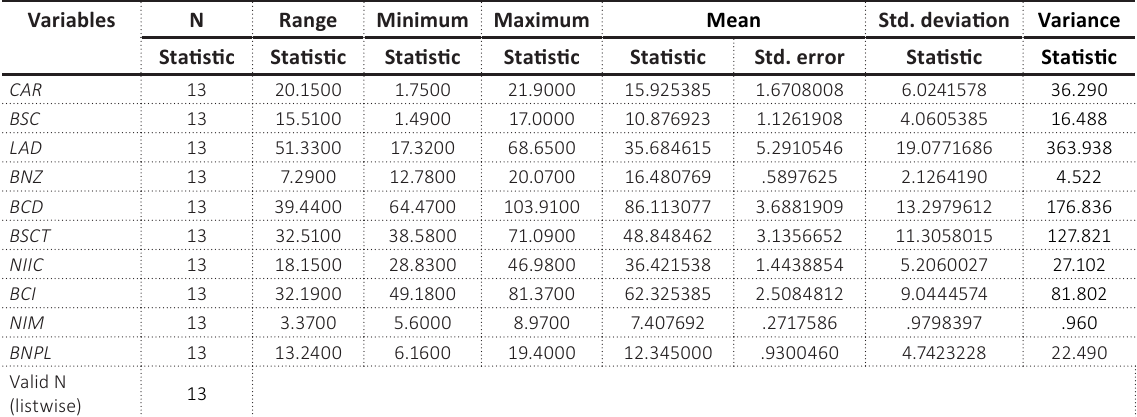
Table 2. Descriptive statistics analysis